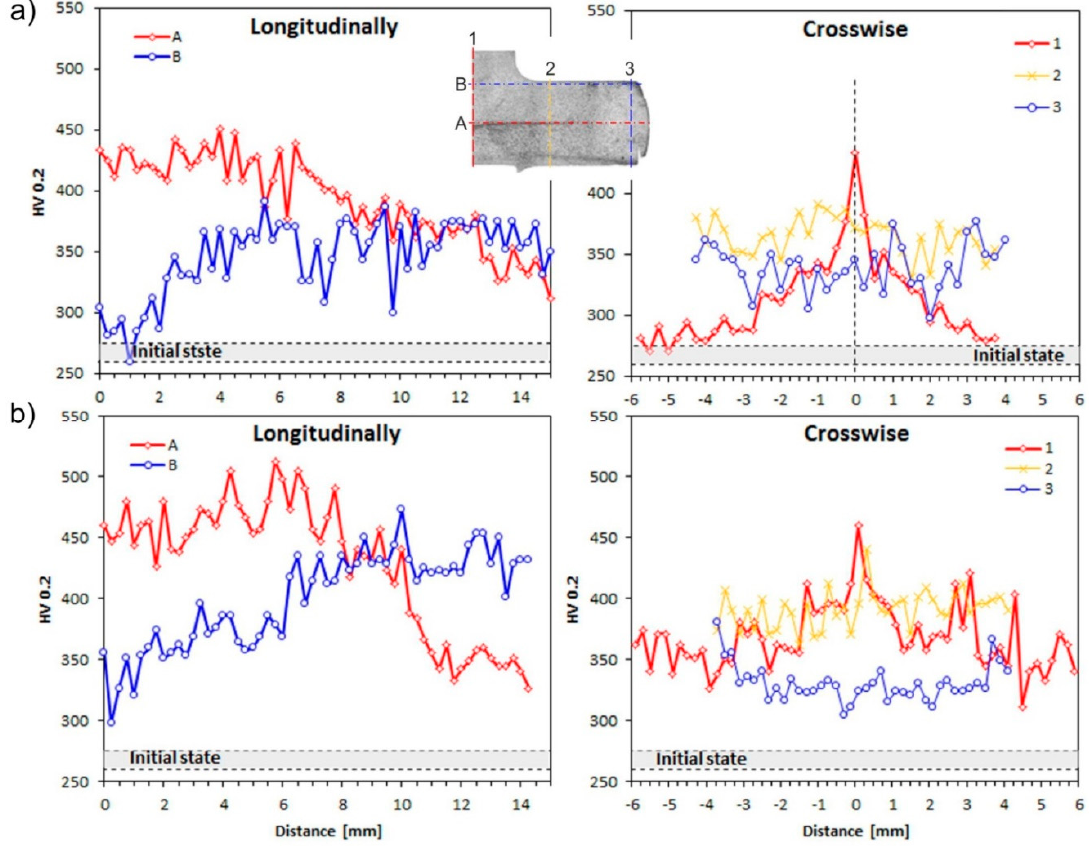
Figure 11. Microhardness of deformed alloy after: ( a ) One and ( b ) two passes of CCE.